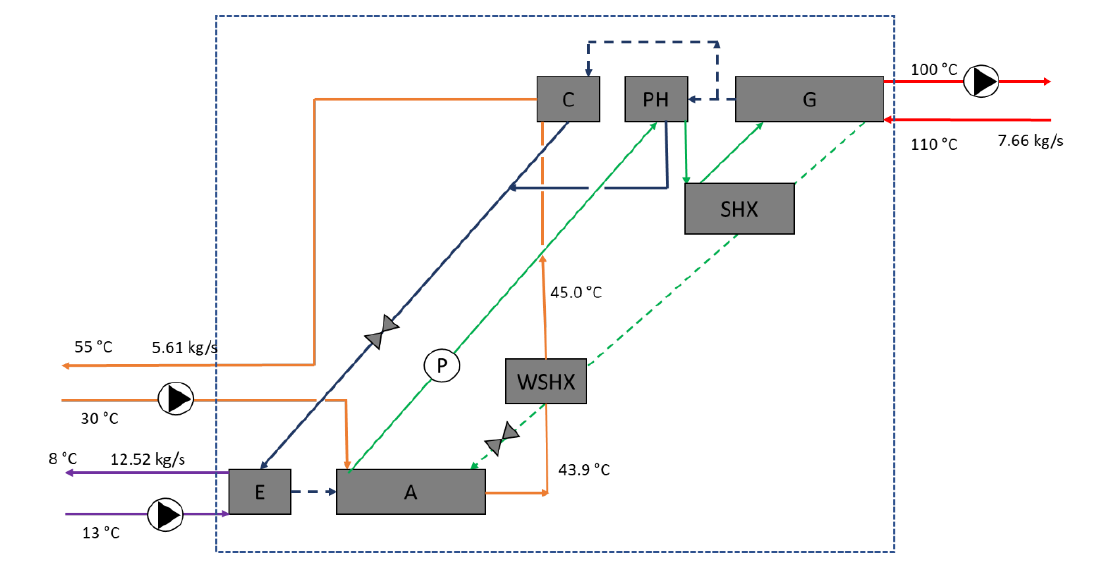
Figure 13. Working temperatures and flow rates for the simultaneous heating and cooling for 4th generation DHC application. Table 4. Absorption heat pump performance for 4th Generation DHC.